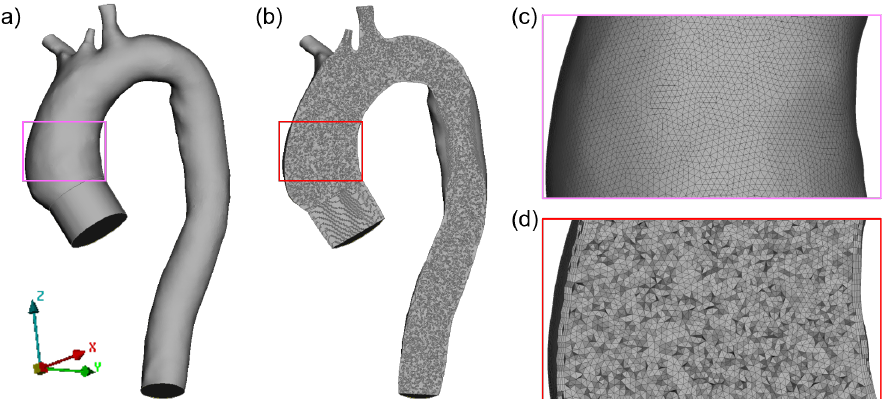
Figure 3. Fluid domain mesh ( a ) and plane cut showing internal elements ( b ) with grid details at wall surface ( c ) and at plane cut ( d